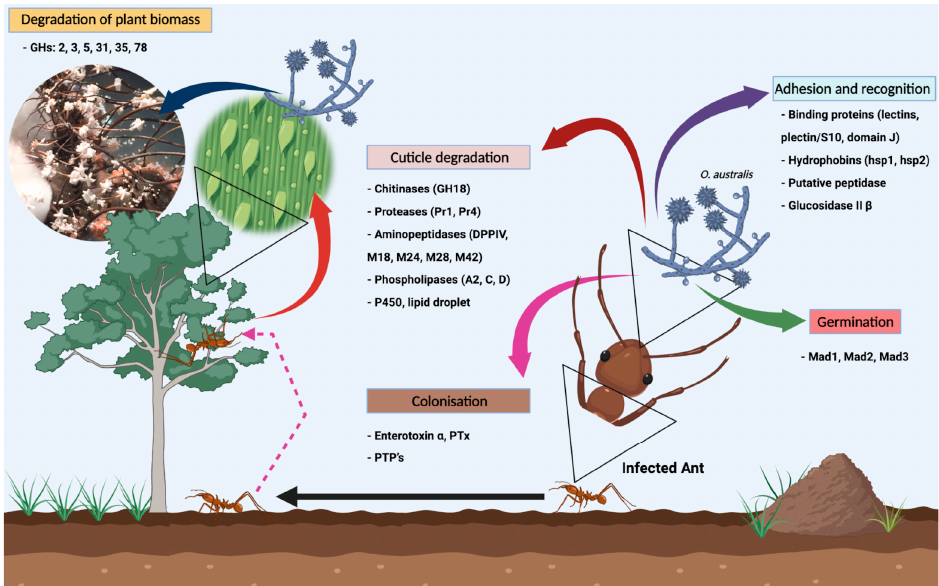
Figure 5. A general overview of the life cycle of the entomopathogenic fungus O. australis (CCMB661), emphasizing all the fungal infection processes in the ant Neoponera curvinodis Forel, 1899. The proteins related to each stage (Adhesion and Recognition), Germination, Cuticle Degradation, and Colonization) are listed.